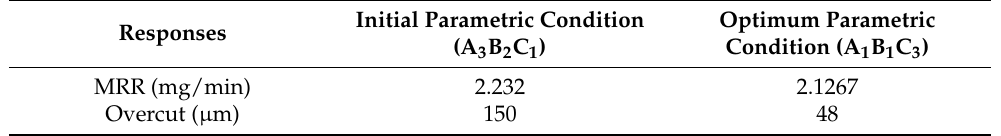
Table 7. Confirmatory test by TOPSIS